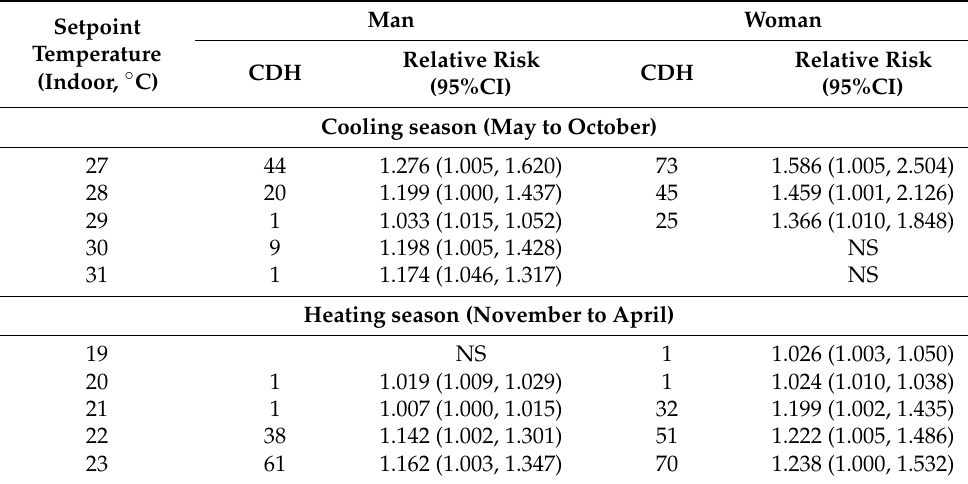
Table 5. Cooling and heating cumulative degree hours for non-infectious respiratory disease-related emergency department visits for older adults from 2006 to 2014 (gender